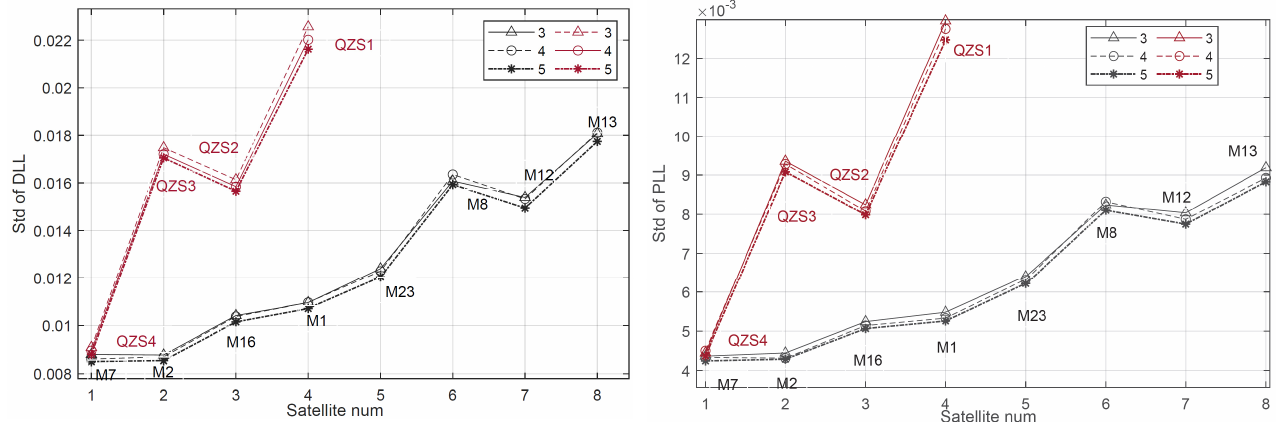
Figure 11. Std of PLL and DLL output for B1C and L1C.